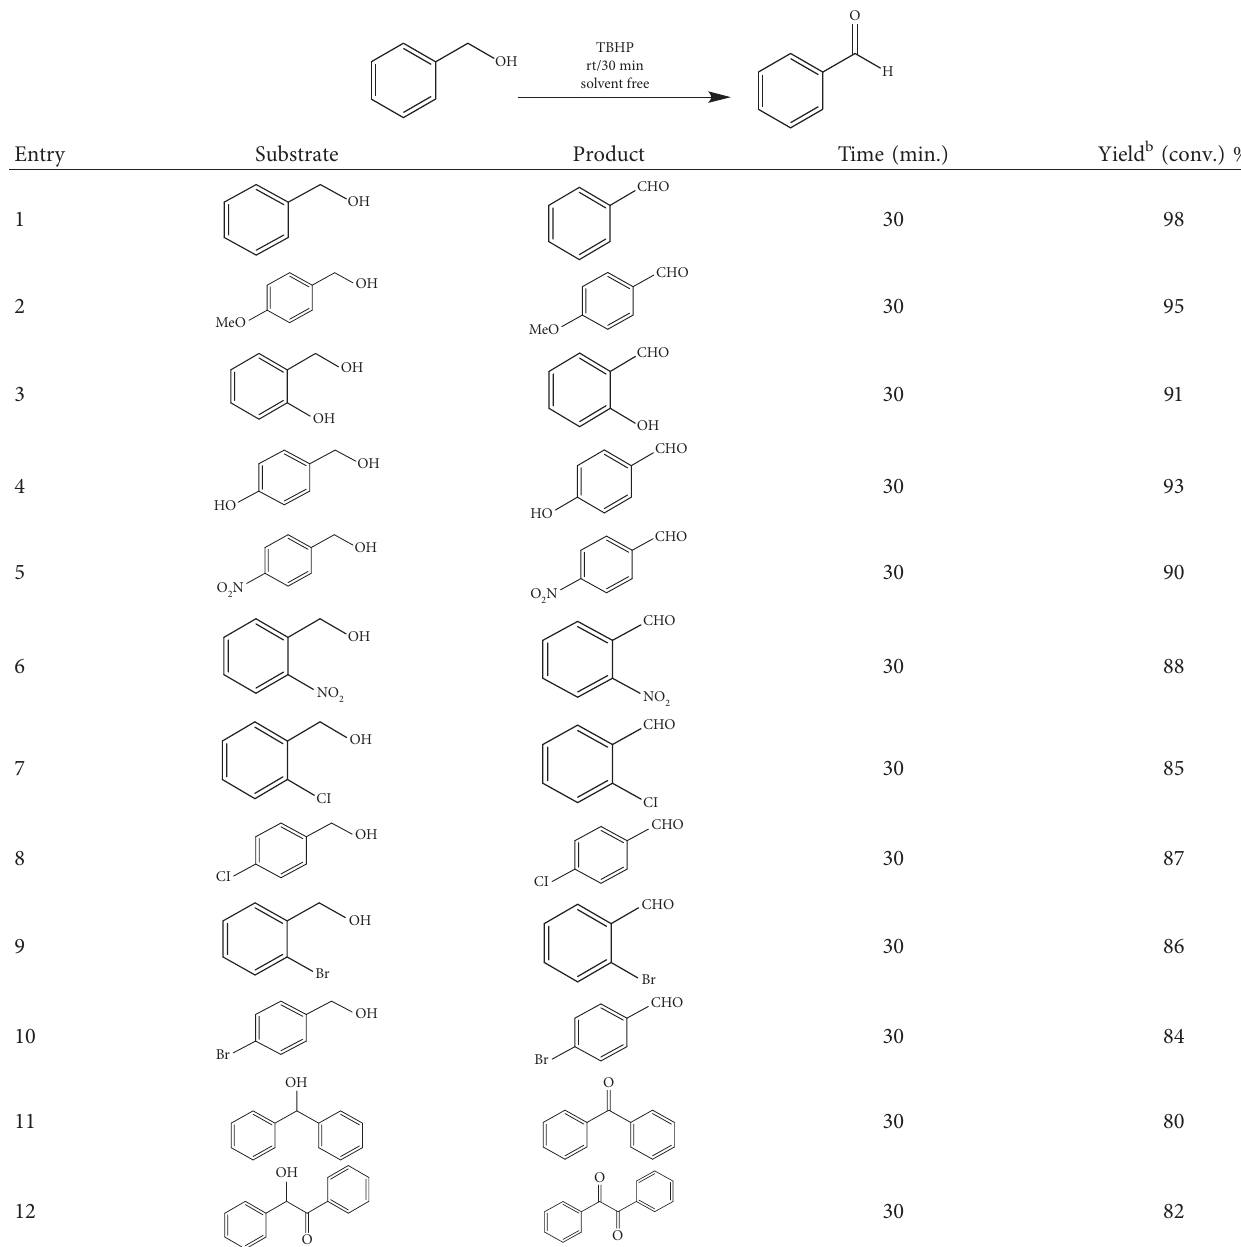
Table 1: Oxidation reactions of various alcohols catalysed by the synthesized catalyst a .